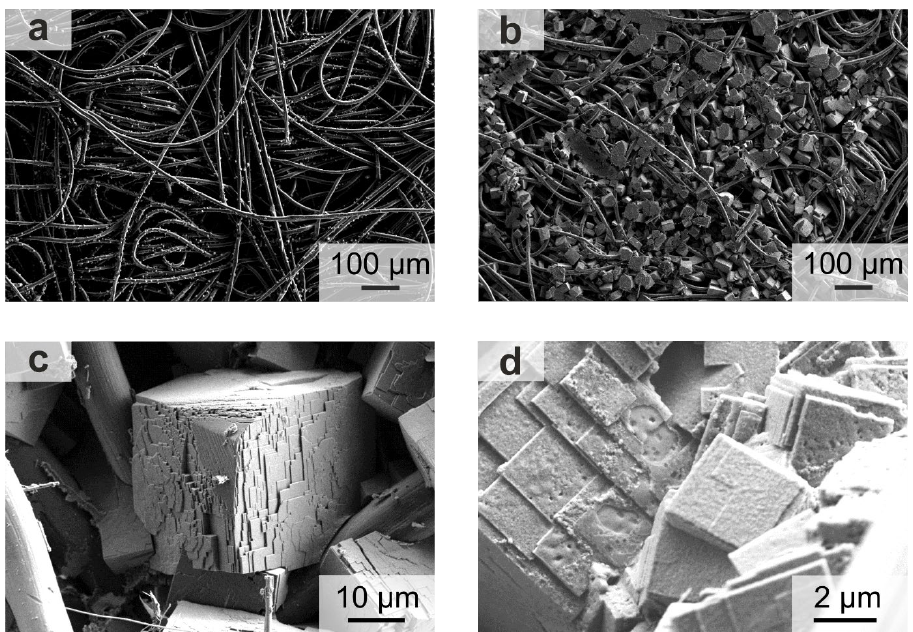
Figure 2. SEM images of the cathode of Na/O 2 batteries after full discharge (100% state of discharge, SOD): ( a ) continuous discharging at 500 µ A cm − 2 , 0.670 mAh; ( b – d ) pulse discharging at 500 µ A cm − 2 SOD): ( a ) continuous discharging at 500 µA cm −2 , 0.670 mAh; ( b – d ) pulse discharging at 500 µA cm −2 with 10 s resting and 1 s pulse, 5.642 mAh. with 10 s resting and 1 s pulse, 5.642